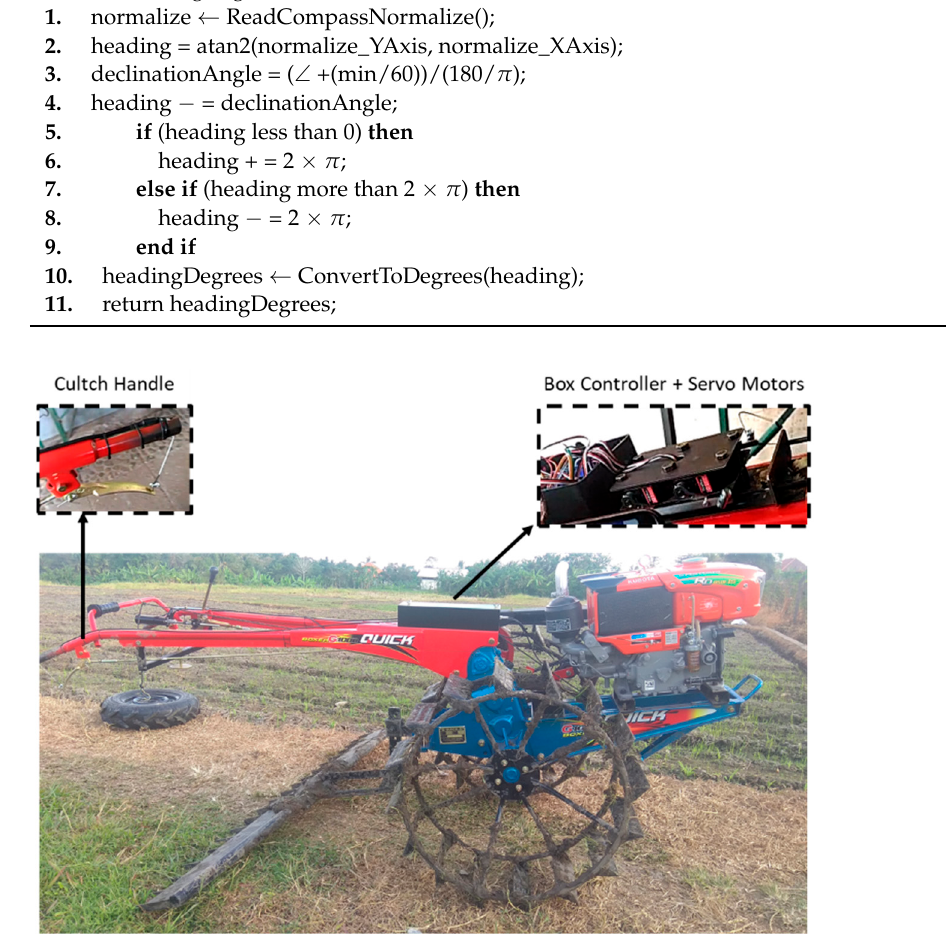
Figure 9. Quick G1000 walk-behind tractor.